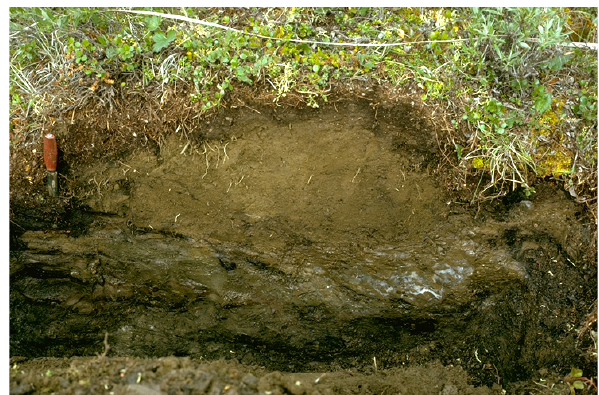
Figure 2. Example of strongly cryoturbated, perennially frozen, mineral soil (Turbel). This soil is associated with the earth hum- mock type of patterned ground. It contains large concentrations of cryoturbated organic materials (the black areas) in the subsoil and has a high ice content. Photograph by C. Tarnocai, previously pub- lished in Jones et al. (2010) and Tarnocai and Bockheim (2011).